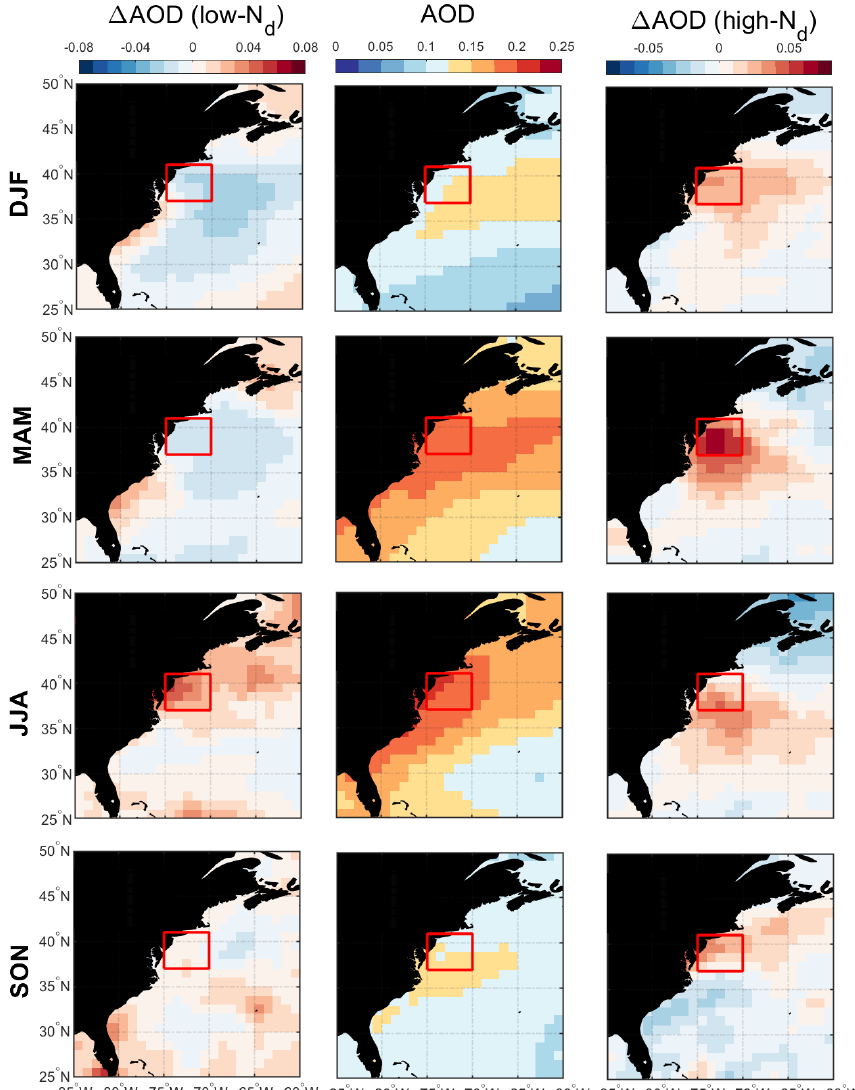
Figure 12. Seasonal averages of MERRA-2 AOD (middle column) and associated anomalies on low- N d days (left column) and high- N d days (right column). The red box represents sub-domain C-N for which the analysis was